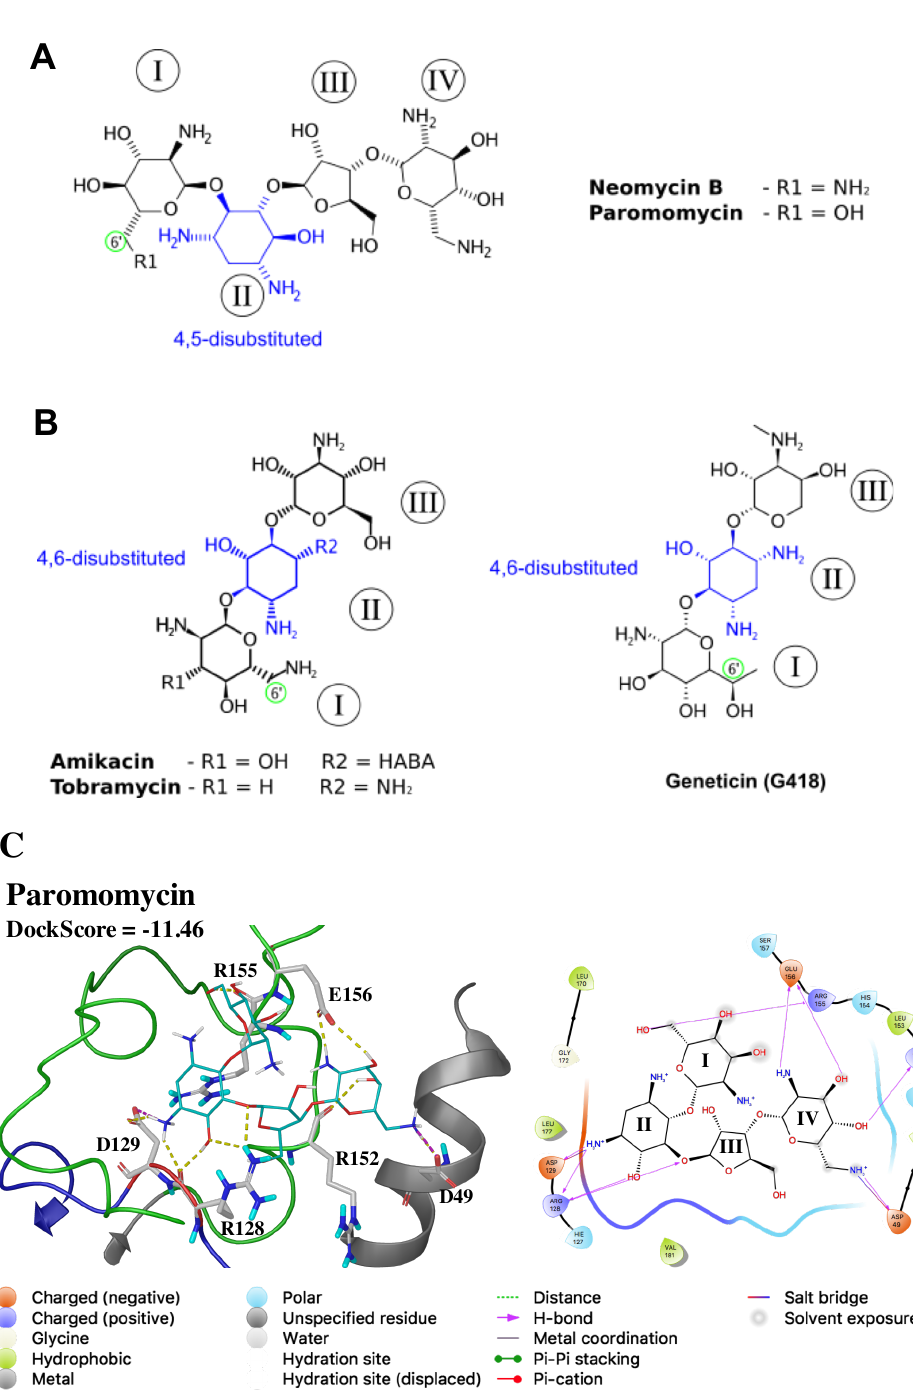
Figure 7. Representative aminoglycosides (AG) antibiotics of 4,5- and 4,6-disubstituted subclasses. Structure representation of ( A ) 4,5-disubsituted AGs (paromomycin and neomycin B) and ( B ) 4,6-disubstituted AGs (amikacin, tobramycin, and geneticin); HABA: α -hydroxy- γ -aminobutyric acid. The position 6 (cid:48) from Ring I is highlighted by a green-colored circle; ( C ) predicted interactions of paromomycin with LmJean3 Site B. The 3D representation of the docking pose is shown on the left (distances up to 2.8 Å), and the ligand interaction diagram (distances up to 4 Å) on the right. Species in the ligand interaction diagram are colored by type: hydrophobic residues green, charged residues red ( − ) or violet ( + ), polar residues light blue and glycine light green. H-bond interactions with amino acids are highlighted as purple lines, salt bridges as blue- and red-colored lines. The figure was prepared using Maestro Schrödinger Release